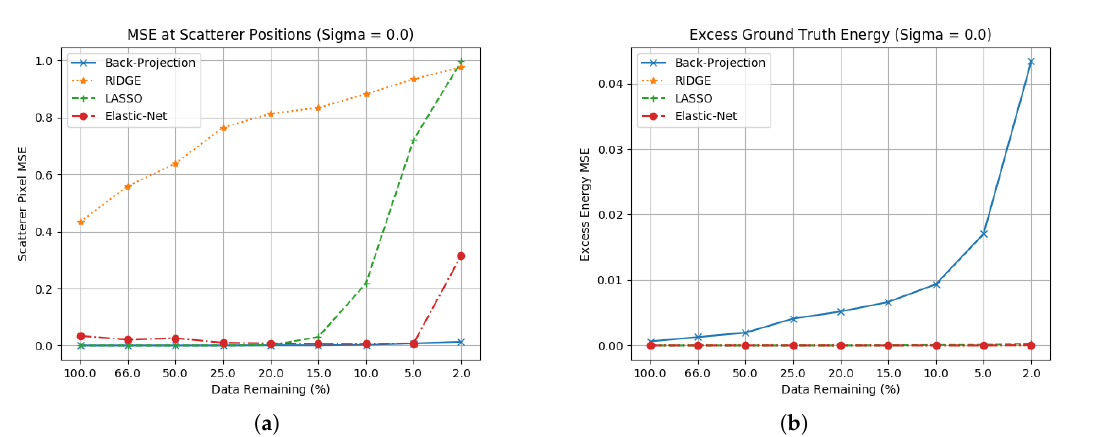
Figure 5. Ground truth estimation statistics for regularised linear regression methods. ( a ) Scatterer location RCS without noise; ( b ) Excess energy without noise.